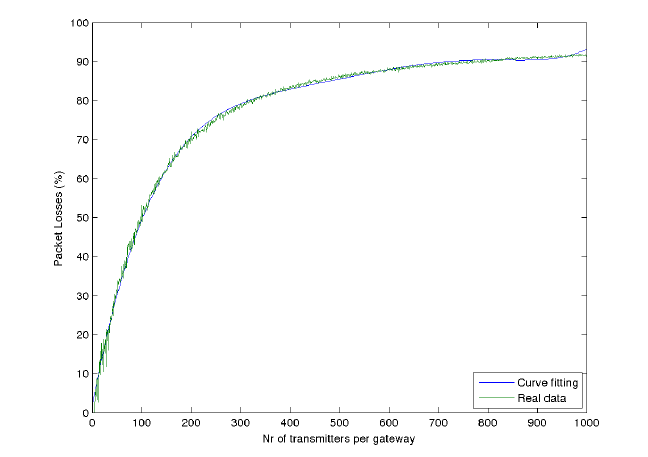
Figure 10. Curve fitting for single channel and SF